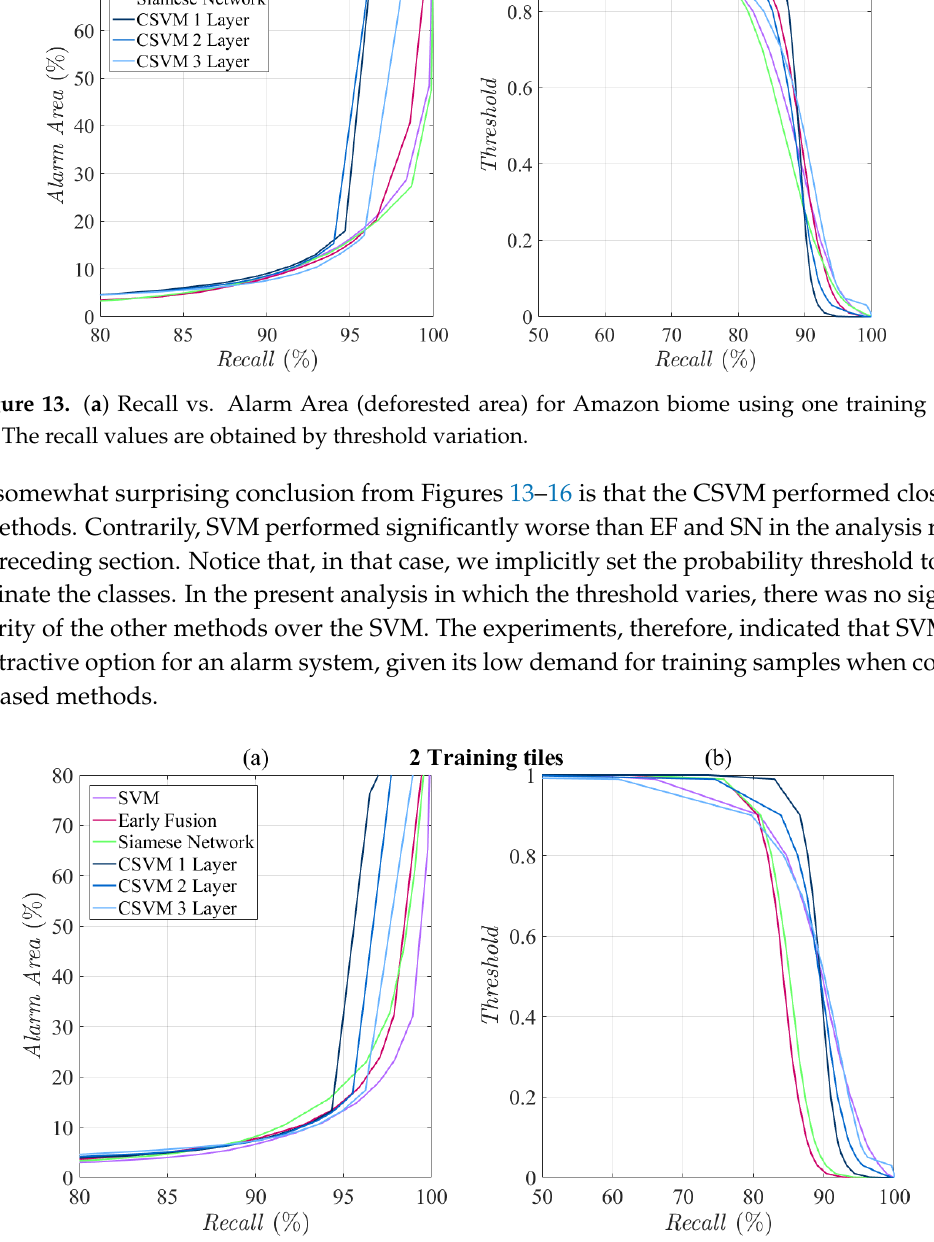
Figure 14. ( a ) Recall vs. Alarm Area (deforested area) for Amazon biome using two training tiles. ( b ) The recall values are obtained by threshold